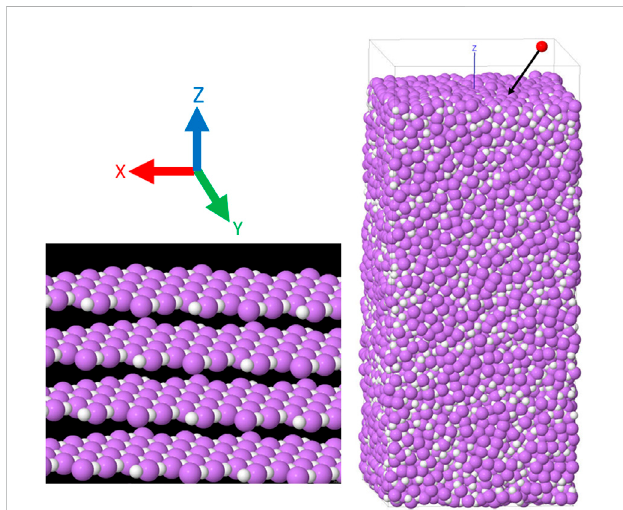
FIGURE 1 An incident particle and LiH surface system. The crystalline LiH structure (left) was transformed by heating and annealing into an amorphous Li + H structure (right), which was bombarded by H and D atoms, varying their point of origin, energy, and angle of incidence at the